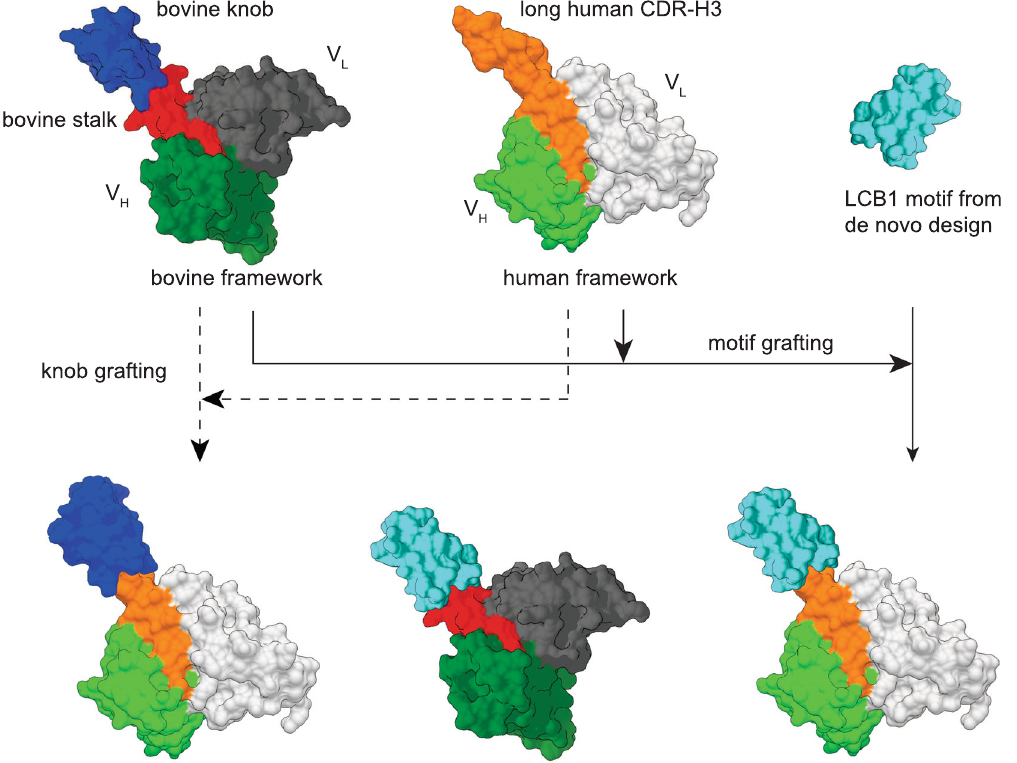
Fig. 6 Design principles for the development of bovine and human antibodies with ultra-long CDRs. Naturally occurring bovine knob can be grafted onto a human antibody scaffold. Peptide motif from de novo design can be grafted either onto bovine or human antibodies. The colors depict the following – bovine knob (dark blue), bovine stalk (red), bovine V H except CDR-H3 (dark green), bovine V L (dark gray), human CDR-H3 (orange), human V H except CDR-H3 (light green), human V L (light gray), motif from de novo peptide LCB1 (light